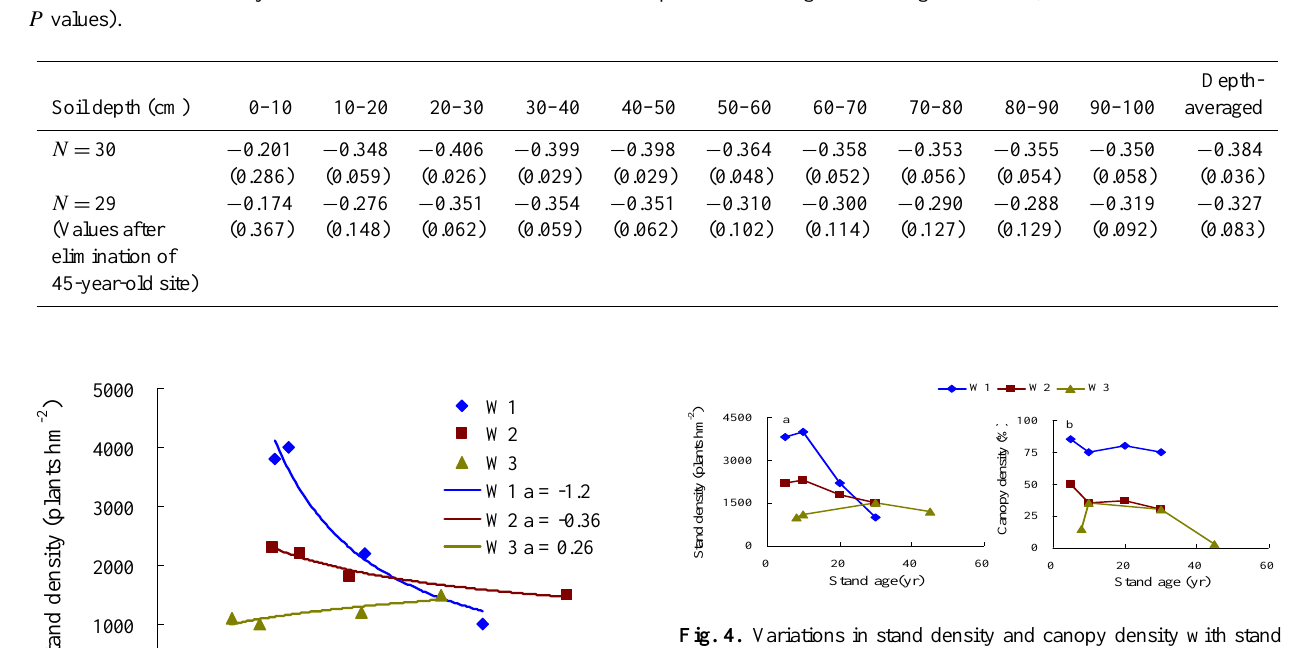
Table 2. Correlation analyses between SMCs measured at different depths and stand ages on the regional scale (correlation coefficients and P values).